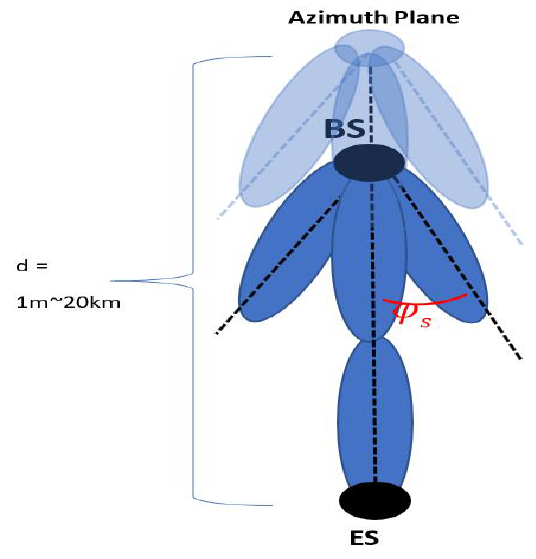
Figure 6. BS-ES relative distance change.